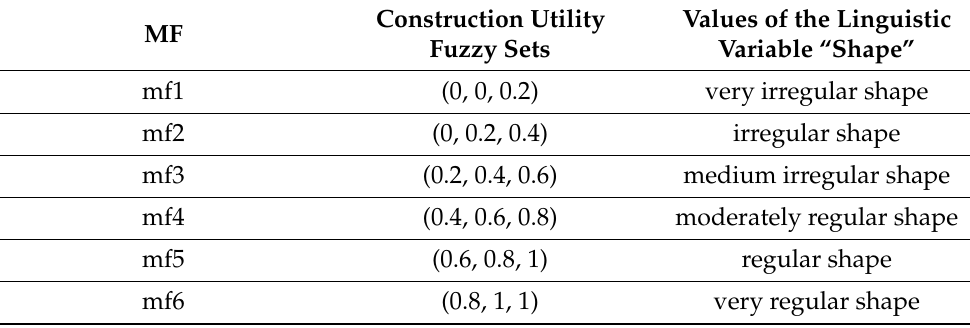
Table 8. Defining fuzzy sets and values of the linguistic variable “Shape”.